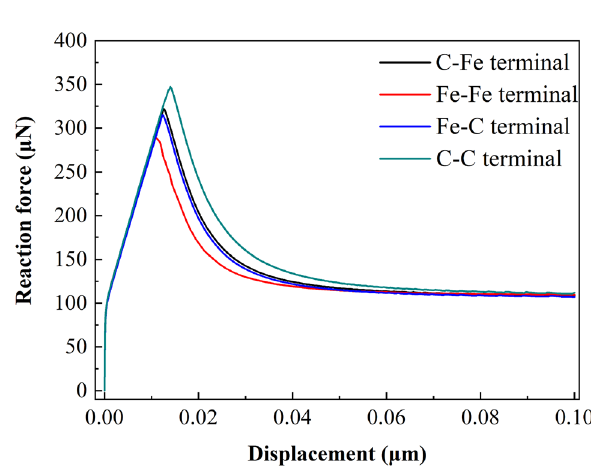
Figure 27. Displacement vs reaction force at loading point (2.5 μm × 2.4 μm).